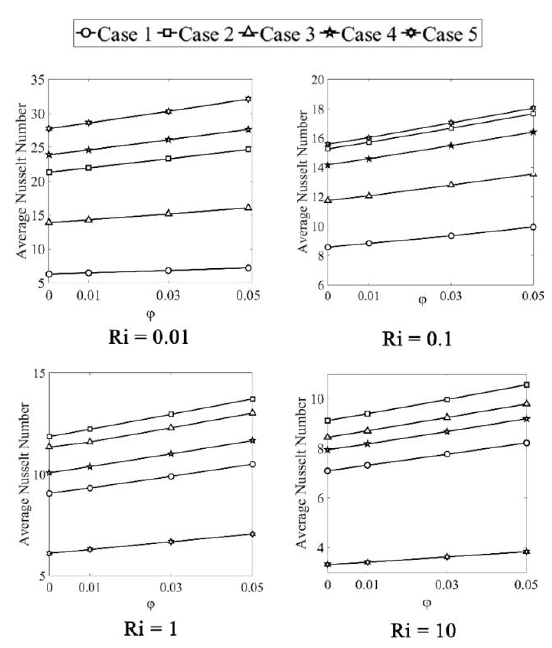
Figure 7. Characteristics of average Nusselt number versus Ø for Ri = 0.01, 0.2, 1 and